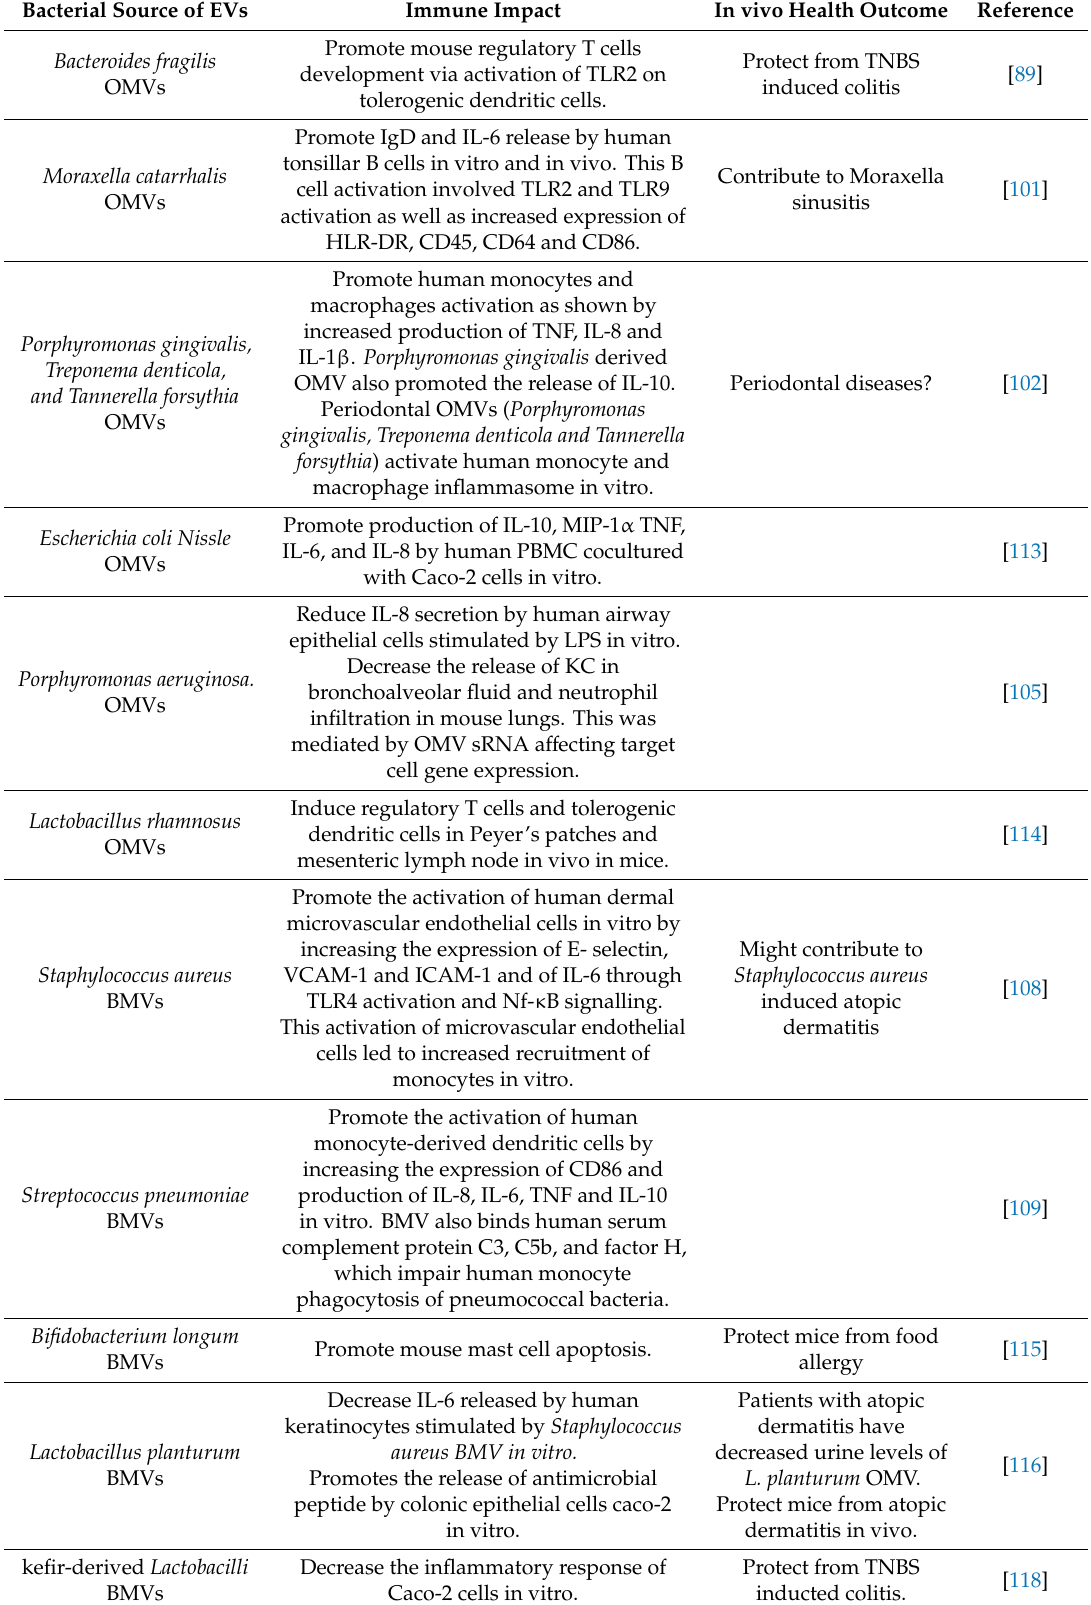
Table 1. Bacterial derived extracellular vesicles, immune function, and impact on diseases. Bacterial Source of